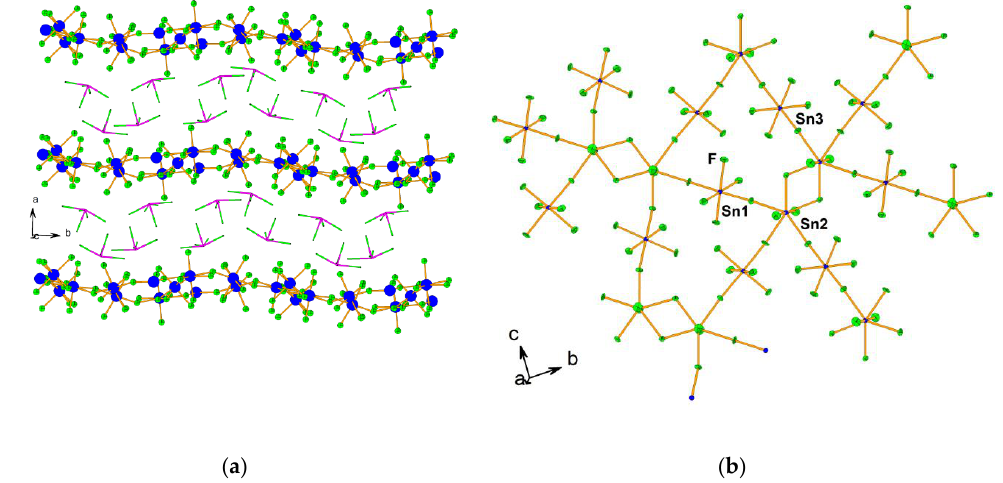
Figure 9. ( a ) Two-dimensional ([Sn 5 F 24 ] 4 − ) ∞ grids with a wave-like conformation and the [XeF 5 ] + cations located between them in the crystal structure of [XeF 5 ] 4 [Sn 5 F 24 ]. For clarity, the [XeF 5 ] + cations are presented with sticks only; ( b ) The ([Sn 5 F 24 ] 4 − ) ∞ layer in the crystal structure of [XeF 5 ] 4 [Sn 5 F 24 ] contains both six- and seven-coordinated Sn(IV) interconnected by bridging fluorine atoms (view perpendicular to the layer, along the a -axis). Copyright (2019) Wiley. Used with permission from Ref.